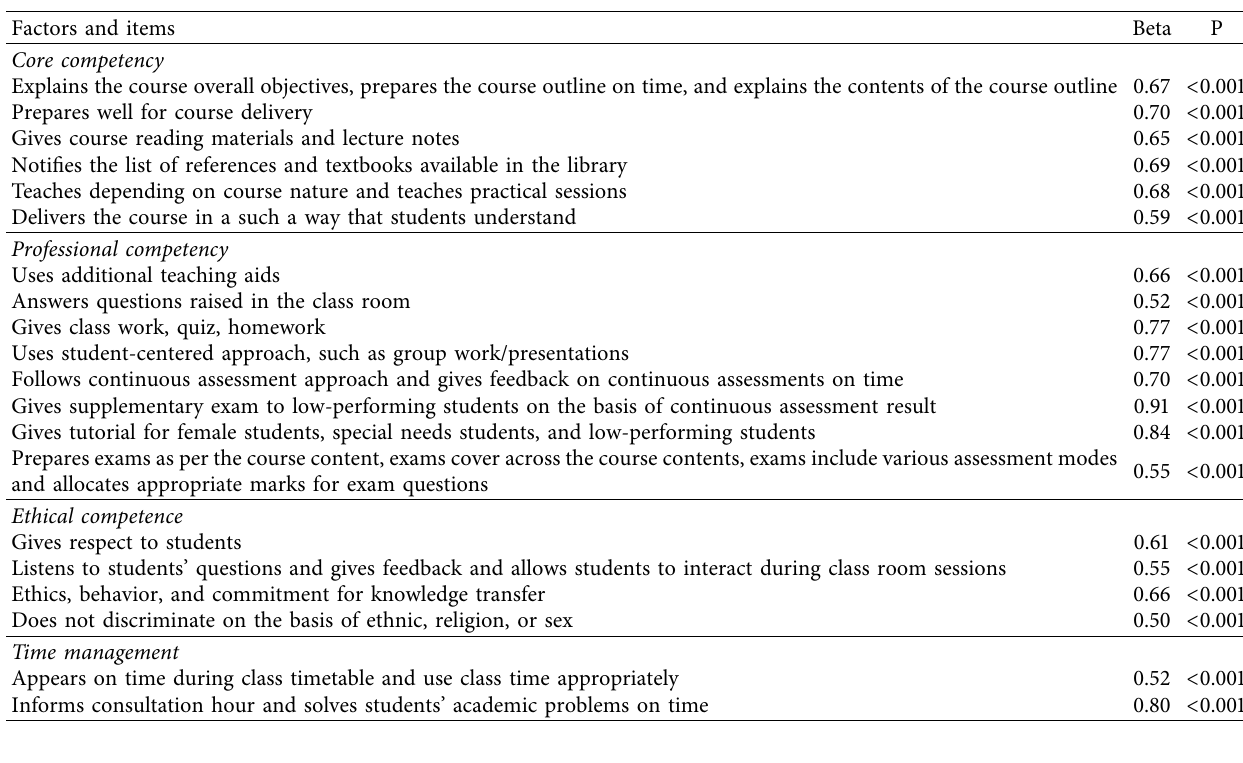
Figure 4: Path Diagram for the two Confirmatory Factor Models. Fc1: factor 1; Fct2: factor 2; CC: Core competency; PC: Professional competency; EC: Ethical competency; TM: Time Table 7: Factor Loadings of the indicator items for the four-factor model.